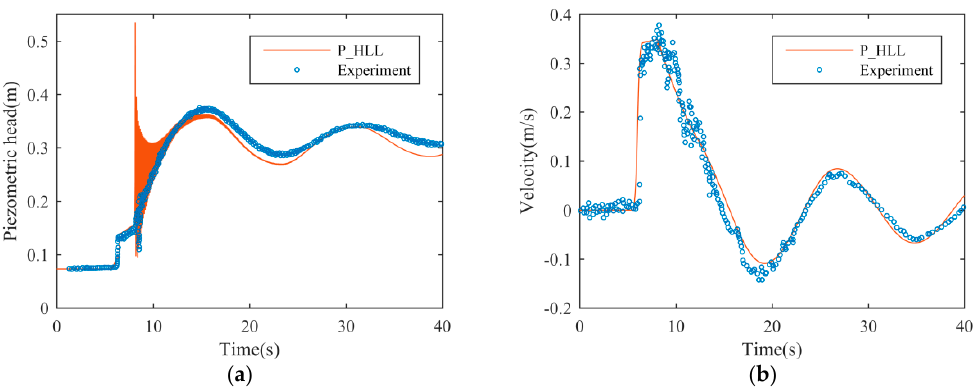
Figure 21. Locus of flow states at x = 9.9 m simulated by P_HLL ( P a = 5 and P b = 0.8) and experimental data: ( a ) piezometric head; ( b ) flow velocity.